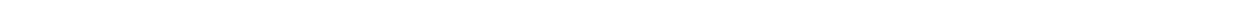
Fig. 6 Loss of p53/Lats2 tumor suppressor allows co-activation of YAP and canonical Wnt activity by DVL. a The 293 cells were transfected with control (dsRed) or shRNA for p53 (dsRed-shp53) in combination with HA-tagged DVL3 expression vector. Whole-cell lysates (WCL) were immunoblotted with indicated antibodies, and nuclear fractions were used for nuclear YAP abundance (left panels). Endogenous YAP localization was determined by confocal microscopy (right panels). Inset, DAPI nuclear stain; Scale bar, 10 μ m. b , c The TEAD ( b ) or TCF/LEF ( c ) reporter constructs were co-transfected with YAP and DVL3 in control transfected cell (dsRed) or shRNA for p53 transfected cells, and the relative reporter activity was measured from